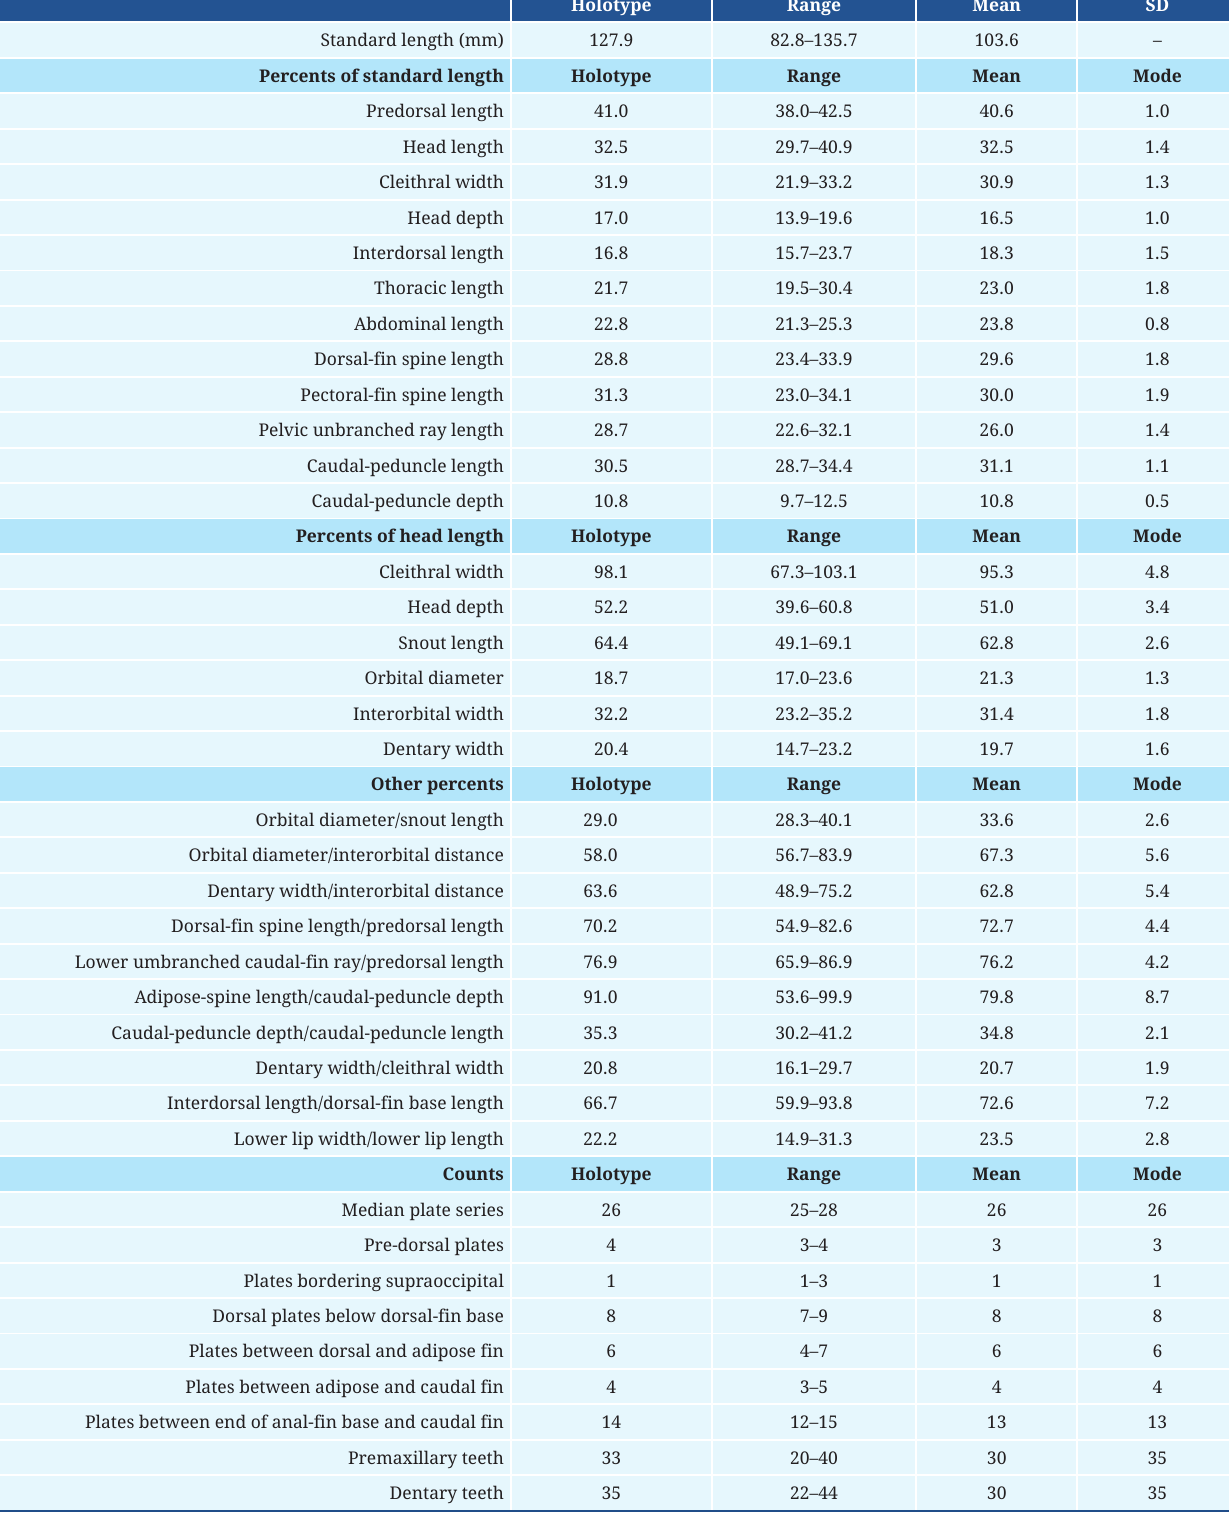
TABLE 3 | Counts and morphometric data of Hypostomus robertsoni . SD, standard deviation. Range includes the holotype and 68